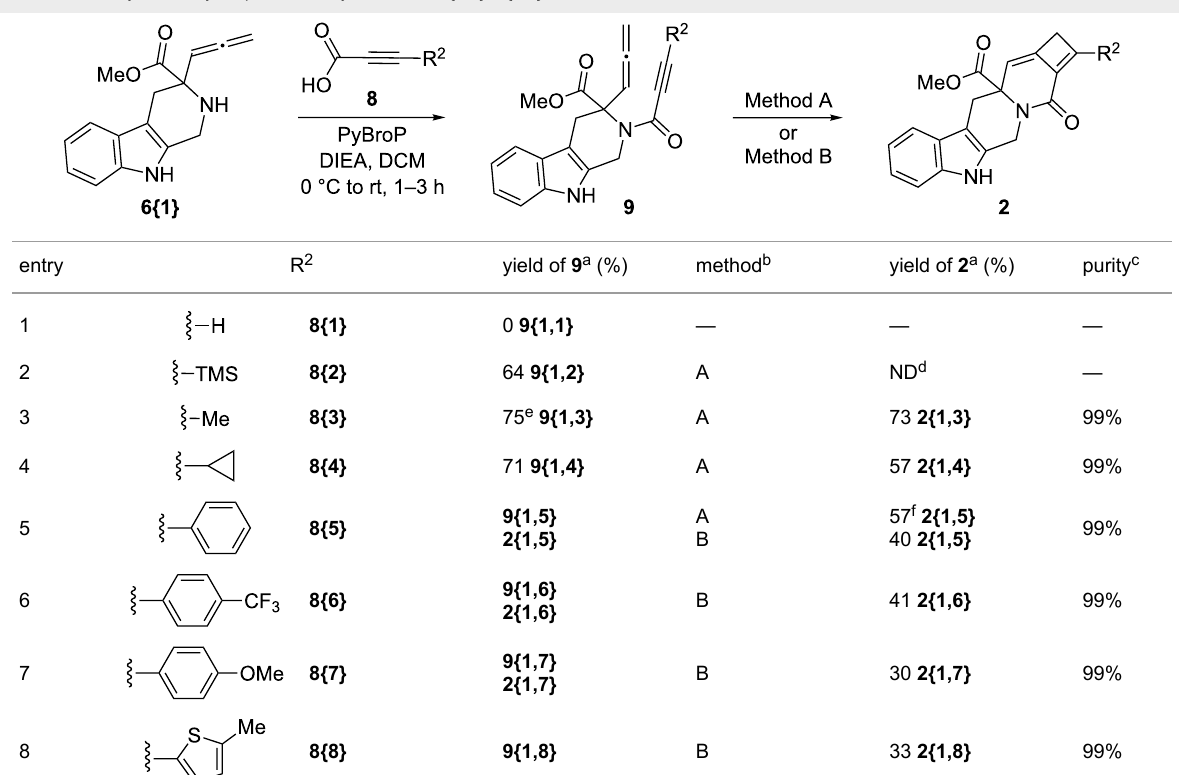
Table 2: Library of tetrahydro- β -carbolinecyclobutenes 2{1,3} – 2{1,8} .